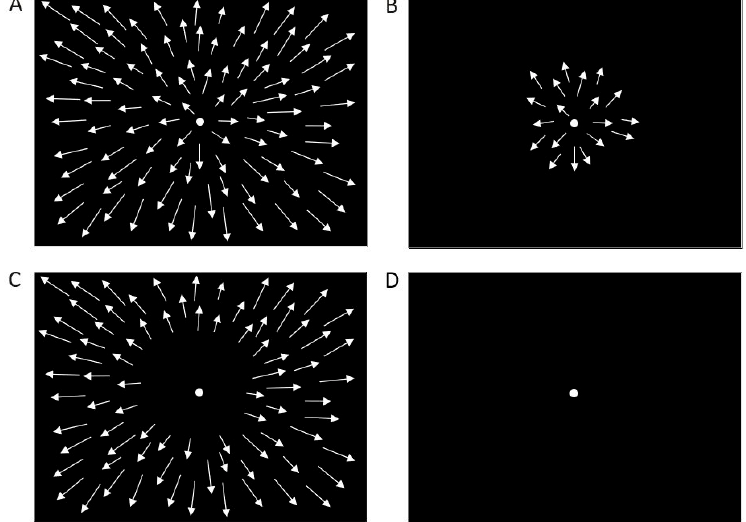
Figure 1. Radial optic flow and control stimuli. ( A ) Full-field stimulus. ( B ) Foveal stimulus. ( C ) Peripheral stimulus. ( D ) Baseline (control). Full, foveal and peripheral stimuli were presented at different speeds: 8, 11, 14, 17 and 20 ◦ /s. The arrows represent the velocity vectors of moving dots. The dots were moving radially from the center to the periphery following a line on each of the 360 ◦